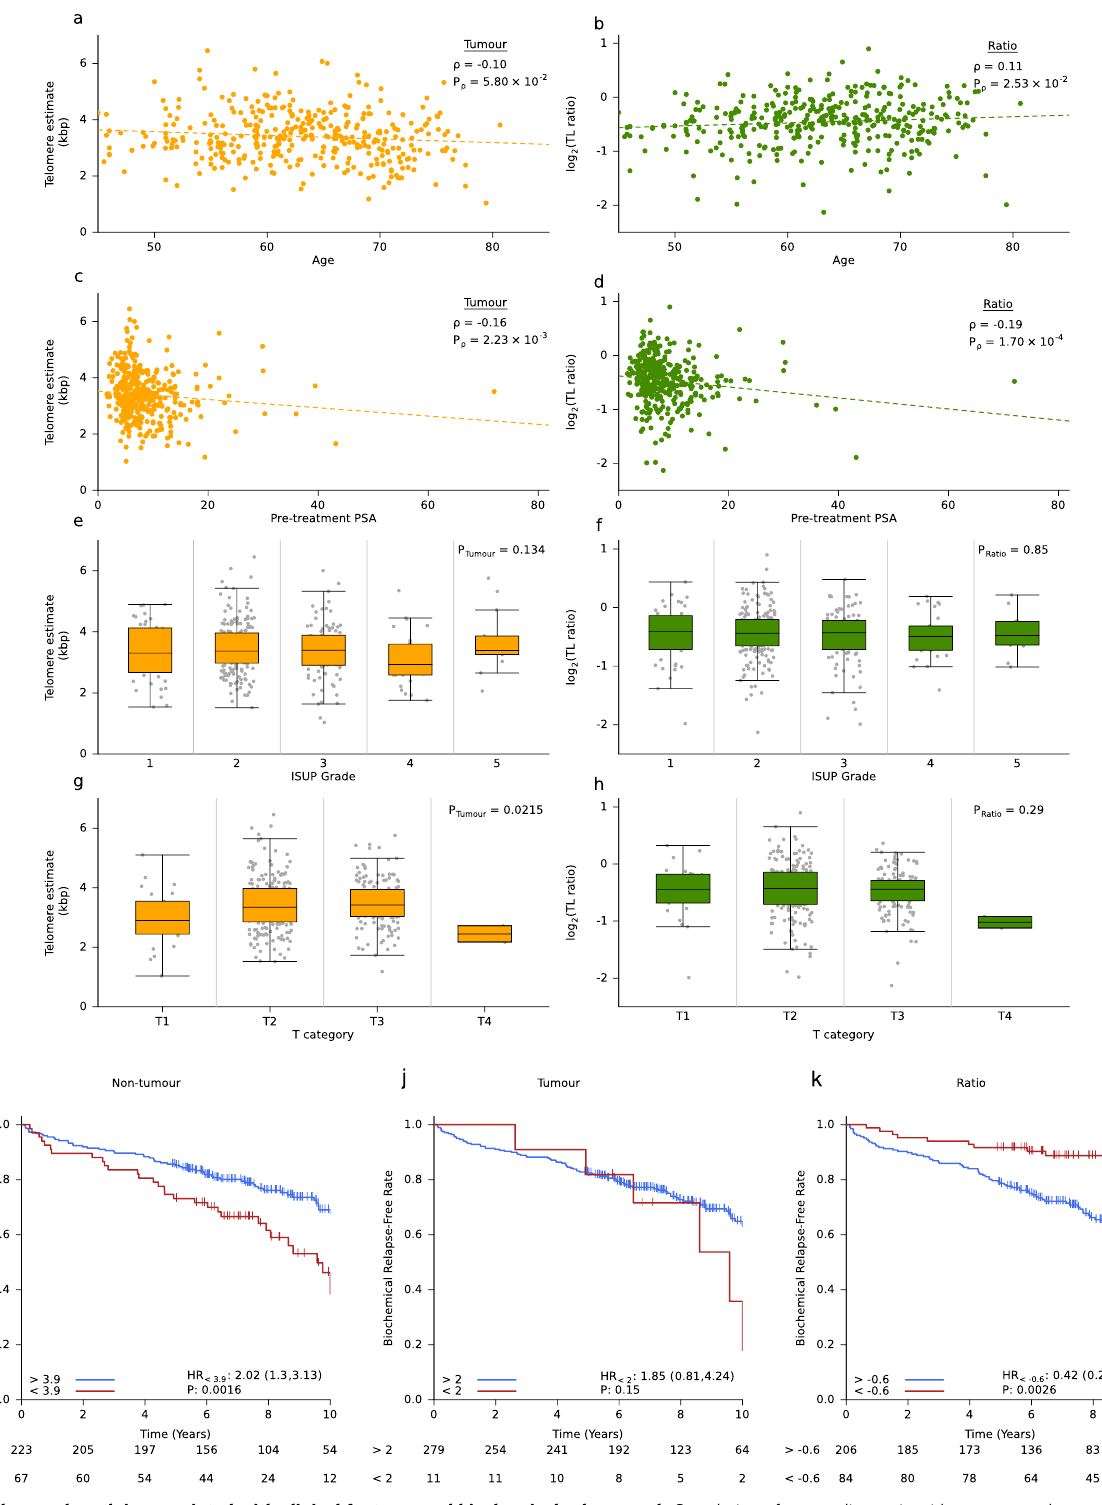
Fig. 6 Telomere length is associated with clinical features and biochemical relapse. a , b Correlation of age at diagnosis with a tumour telomere length (TL) and b TL ratio. Spearman ’ s ρ and P -values are displayed, two-sided. c , d Correlation of pre-treatment prostate speci fi c antigen (PSA) with c tumour TL and d TL ratio. Spearman ’ s ρ and P -values are displayed, two-sided. e , f Association of ISUP (International Society of Urological Pathology) grade with e tumour TL and f TL ratio. P -value is from a one-way ANOVA, n = 381. Box plots depict the upper and lower quartiles, with the median shown as a solid line; whiskers indicate 1.5 times the interquartile range (IQR). g, h Association of T category with g tumour TL and h TL ratio. P -value is from a one-way ANOVA, n = 381. Box plots depict the upper and lower quartiles, with the median shown as a solid line; whiskers indicate 1.5 times the interquartile range (IQR). On all plots, green indicates TL ratio, while orange indicates tumour TL. i , k Cox proportional hazard models were created for i non-tumour TL, j tumour TL and k TL ratio with biochemical relapse (BCR) as the endpoint. Samples ( n = 290) were split into two groups based on the optimal cut point analysis